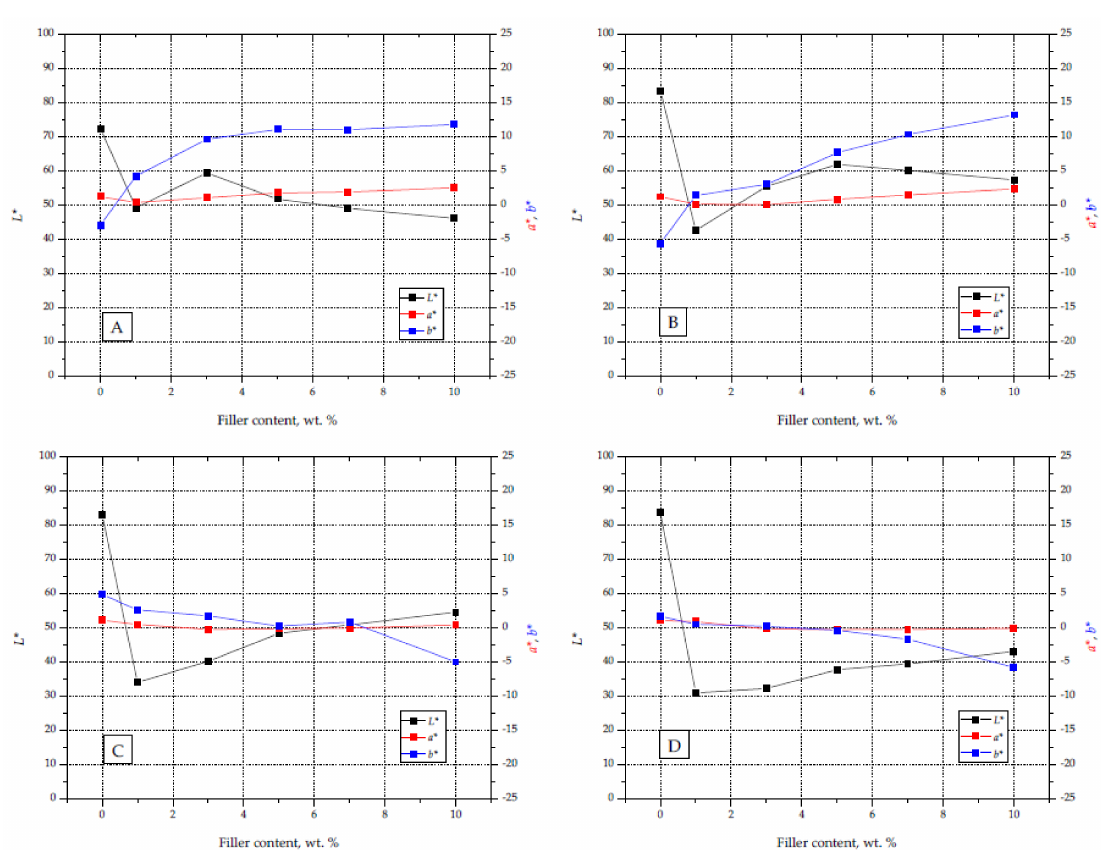
Figure 10. Charts with L* , a* , and b* parameters for graphic signs made on samples with different filler content and different laser beam parameters ( A – D